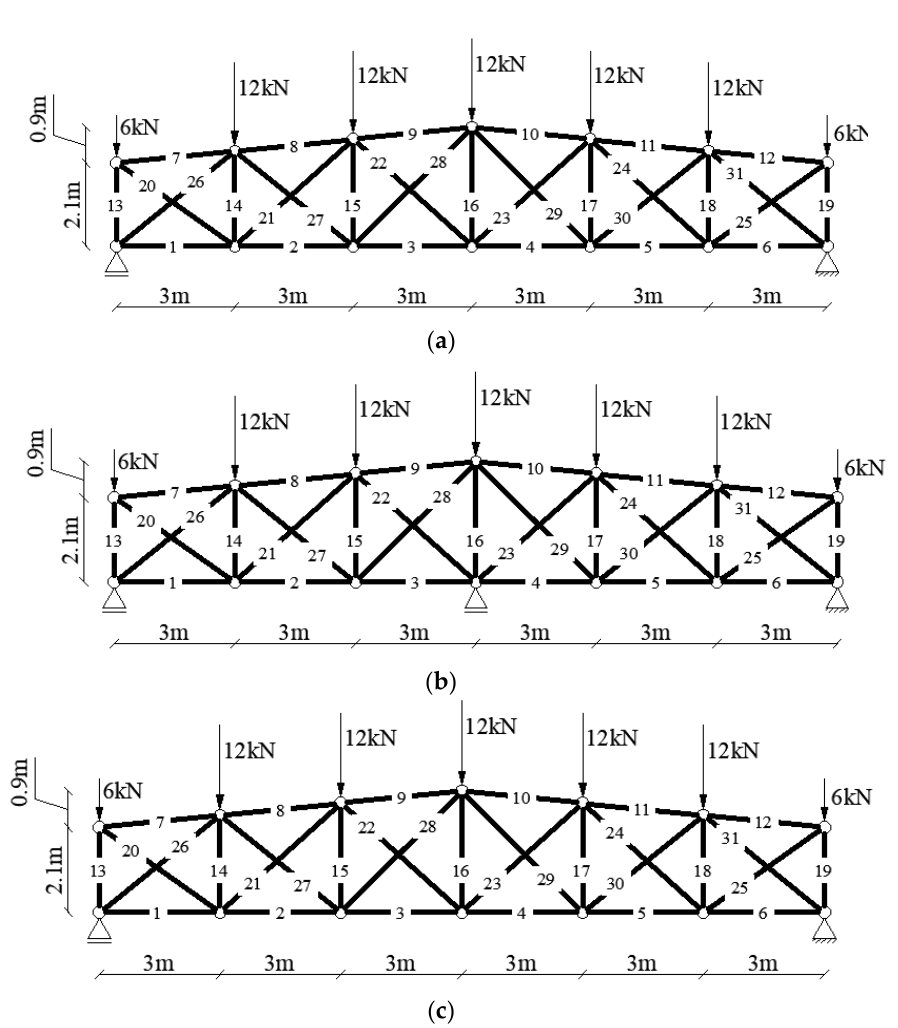
Figure 2. Geometry of analyzed trusses: ( a ) a truss with one hinged movable support and one hinged nonmovable support (truss “0”); ( b ) a truss with an additional intermediate support (truss “A”); and ( c ) a truss with the blockade of free thermal deformations (truss “B”).